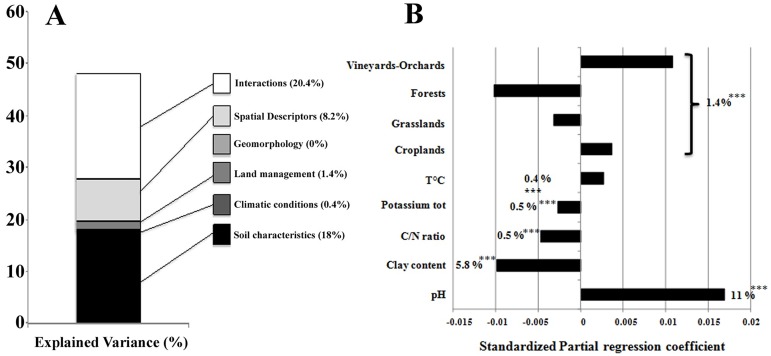
Variance partitioning, contribution and effect of model parameters for the distribution of bacterial richness on the scale of France.(A) Variance partitioning of bacterial richness. The amount of explained variance corresponds to the adjusted R2 values of the contextual groups using partial redundancy analysis. The significance level of the contribution of the sets of variables is at least P < 0.01. (B) Model parameters for the distribution of bacterial richness on the scale of France. Each parameter is presented with its estimated model coefficients and its marginal effect assessed by a permutation test. P<0.01: **, P<0.001: ***. Missing values indicate that the variable was not retained in the model. Sand was removed prior to model evaluation since it was represented by the opposite of the sum of silt and clay contents.